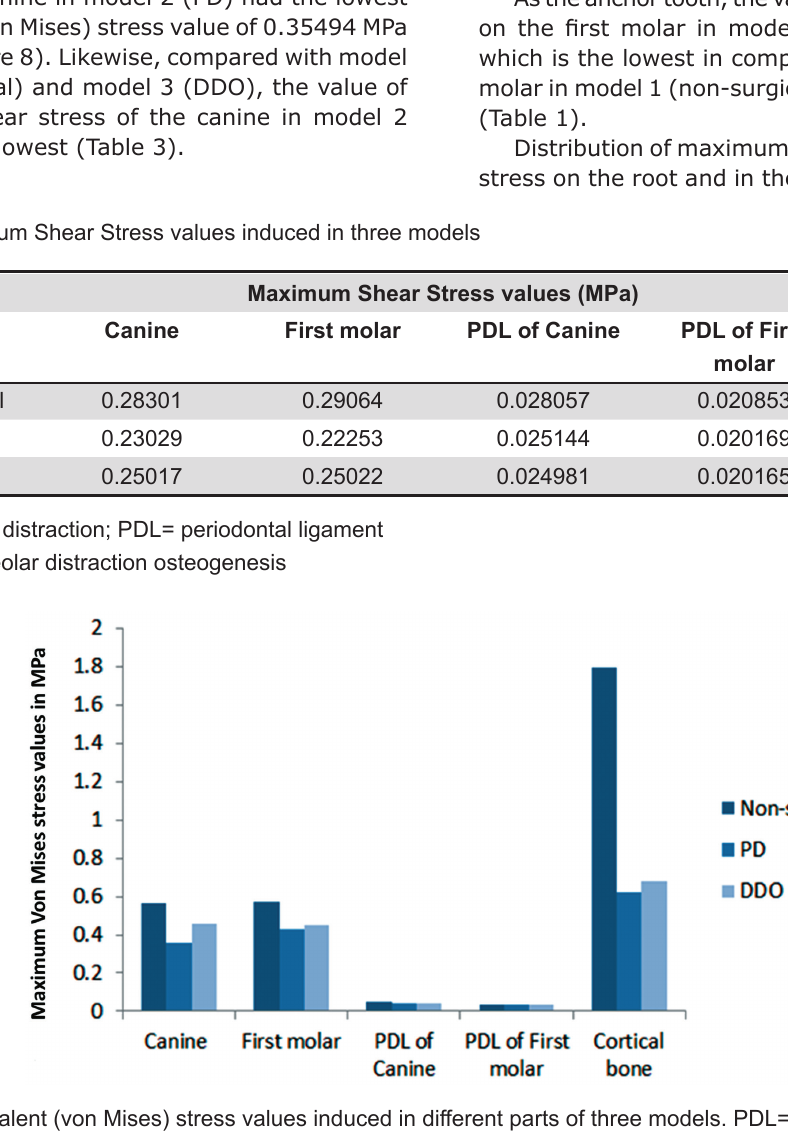
Figure 8- Equivalent (von Mises) stress values induced in different parts of three models. PDL= periodontal ligament